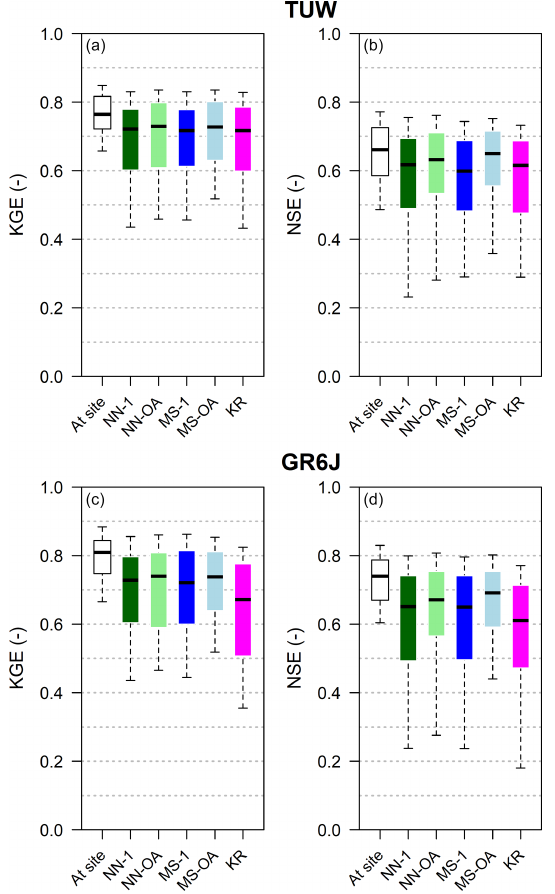
Figure 7. Original performances of the regionalisation methods for TUW (a, b) and the GR6J model (c, d) for the 209 Austrian catch- ments in the validation period 1992–2008. Boxes extend to 25% and 75% quantiles, while whiskers refer to 10% and 90% quan- tiles.